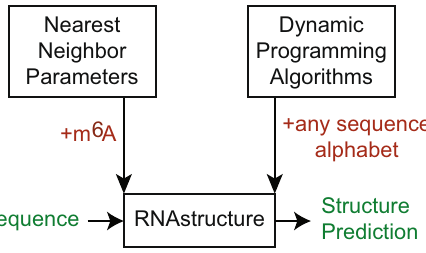
Fig. 1 Overview. In this study, we advanced the RNAstructure software package 40 (at center) to be capable of predicting secondary structures for sequences with the m 6 A nucleotide. RNA secondary structure prediction by RNAstructure relies on nearest neighbor parameters for estimating folding stability and dynamic programming algorithms for estimating structures and base pair probabilities. Here we fi tted nearest neighbor parameters for m 6 A to optical melting data and revised software to be capable of considering any user-speci fi ed sequence